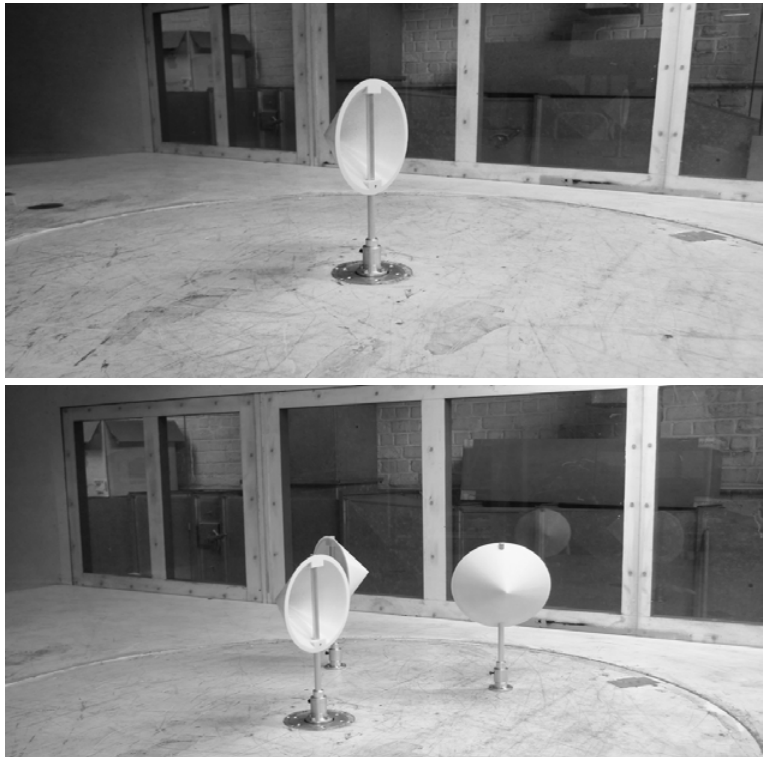
Figure 7. Both cup configurations measured in the wind tunnel of the Vrije Universiteit Brussel: isolated cup ( top ), and cup inside a 3-cup rotor ( bottom